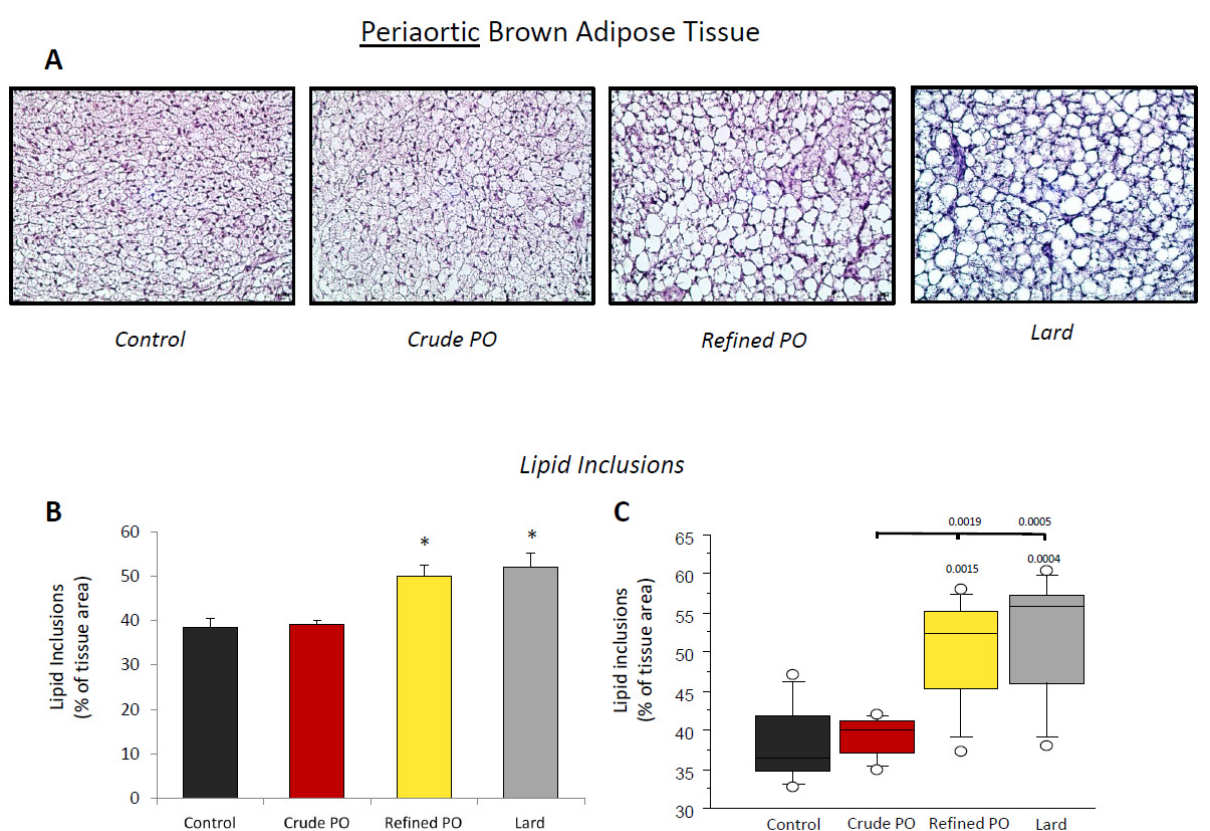
Figure 3. Lipid inclusions in periaortic brown adipose tissue (AoBAT). ( A ) Representative microphotographs of haema- toxylin staining (×200; scale bar = 20 µm); ( B ) quantitative analysis of lipid inclusions as % of total tissue area; ( C ) box plot displaying the distribution of lipid inclusions. Quantification of lipid inclusion was realised in 10–30 fields per rat. Data are shown as means ± SEM, n = 7 animals per group. * p < 0.05 vs. control diet.